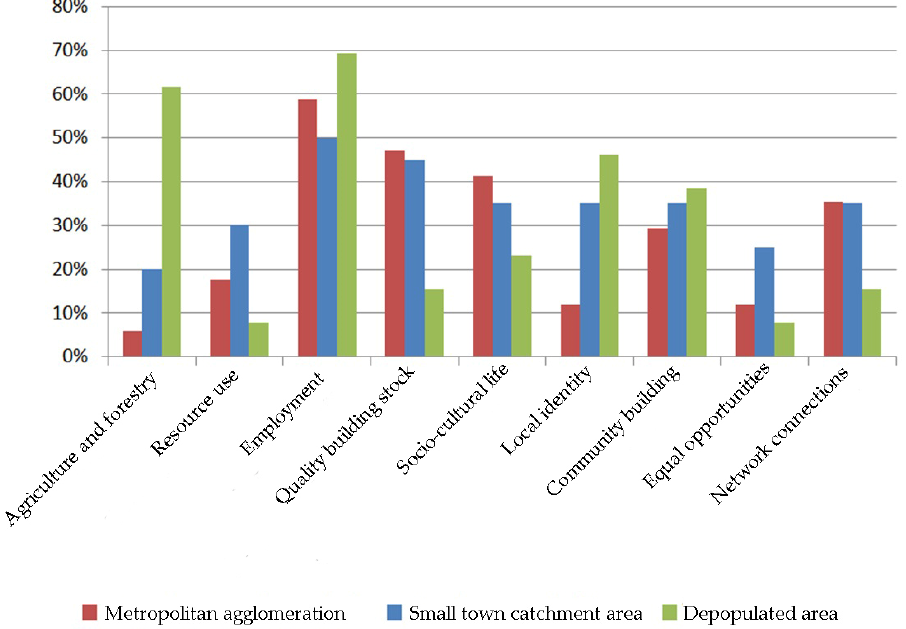
Figure 4. Development emphases depending on the role of the settlement network.